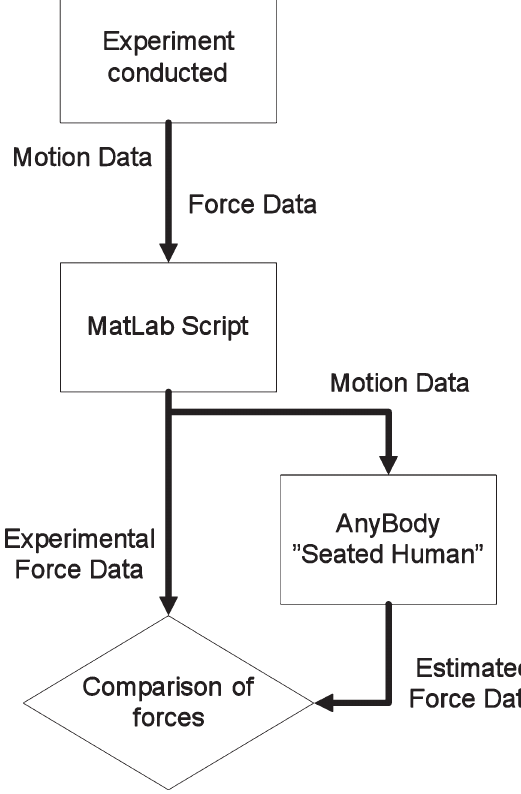
Fig. 1. Flow chart of the study design. Recording and post pro- cessing of experimental data using a Matlab script, transfer of the kinematicdatatothemusculo-skeletalmodelforsimulationofforces and finally comparison between measured and calculated